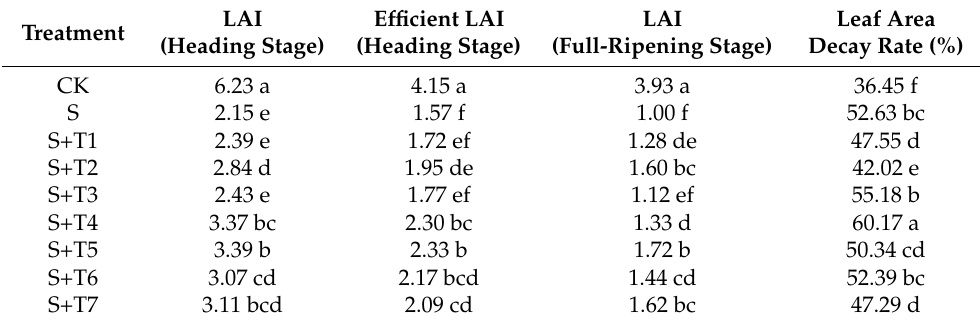
Table 4. Rice LAI, efficient LAI, and leaf area decay rate.